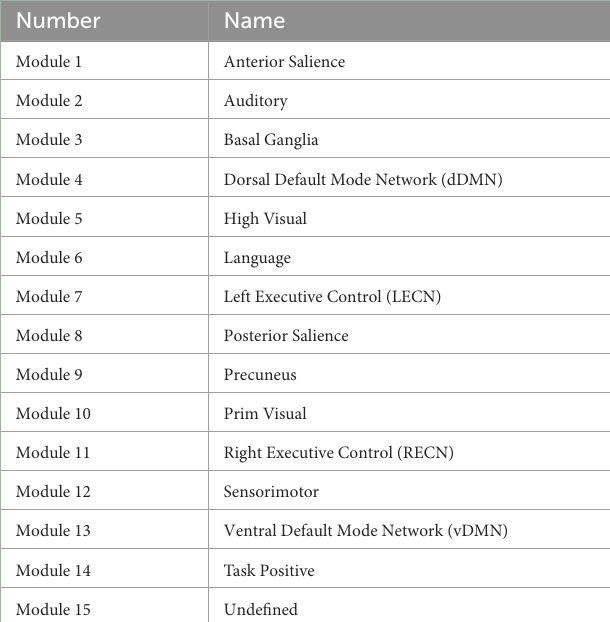
TABLE 2 Findlab-based modules (Shirer et al., 2012) used in our application